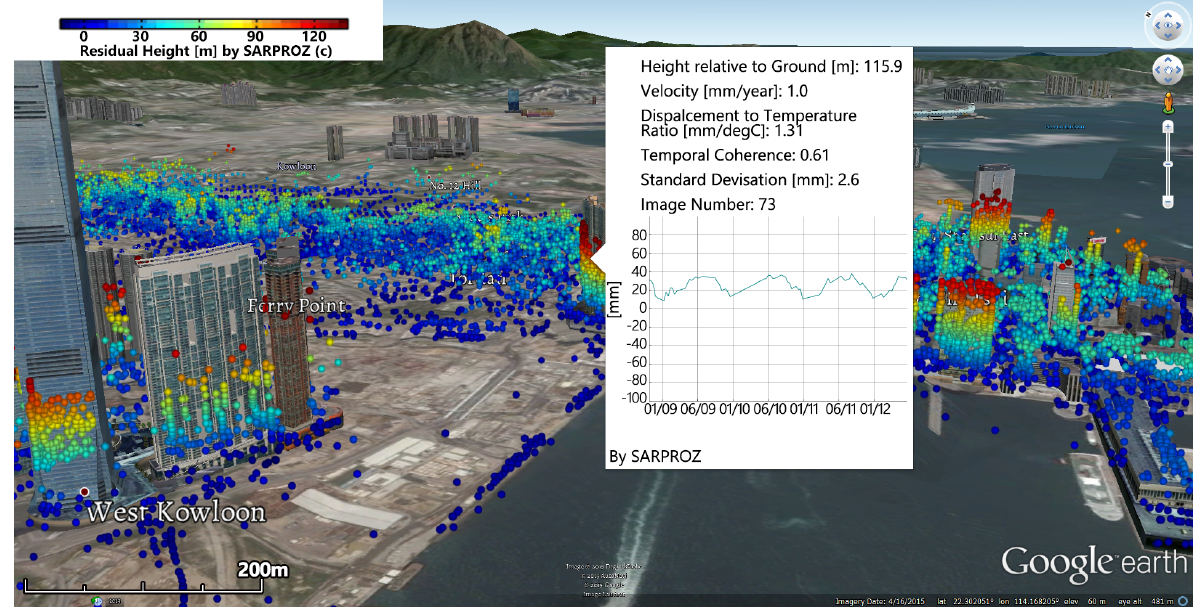
Figure 9. Displacement time series for a PS point detected on the façade of the